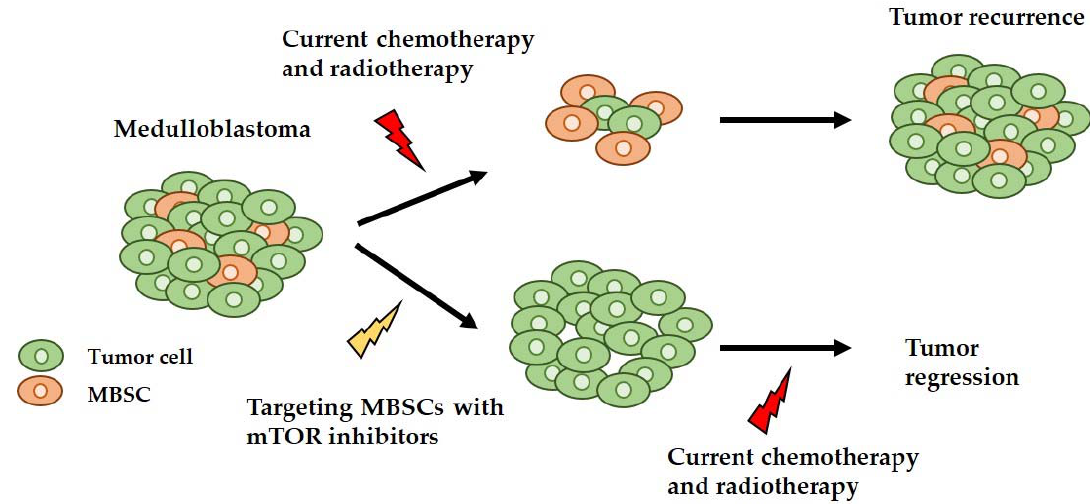
Figure 3. Schematic representation of a possible new approach to target medulloblastoma stem cells (MBSCs)s and MB. Medulloblastoma has an intracellular heterogeneity, having different cell types, such as normal tumor cells and MBSCs. With the classic treatment, the elimination of normal tumor cells is achieved, and the surviving MBSCs can form the tumor again. With the proposed new approach, the MBSCs are eliminated using mTOR inhibitors and the tumor cells are eliminated using the conventional therapy, achieving total tumor regression.